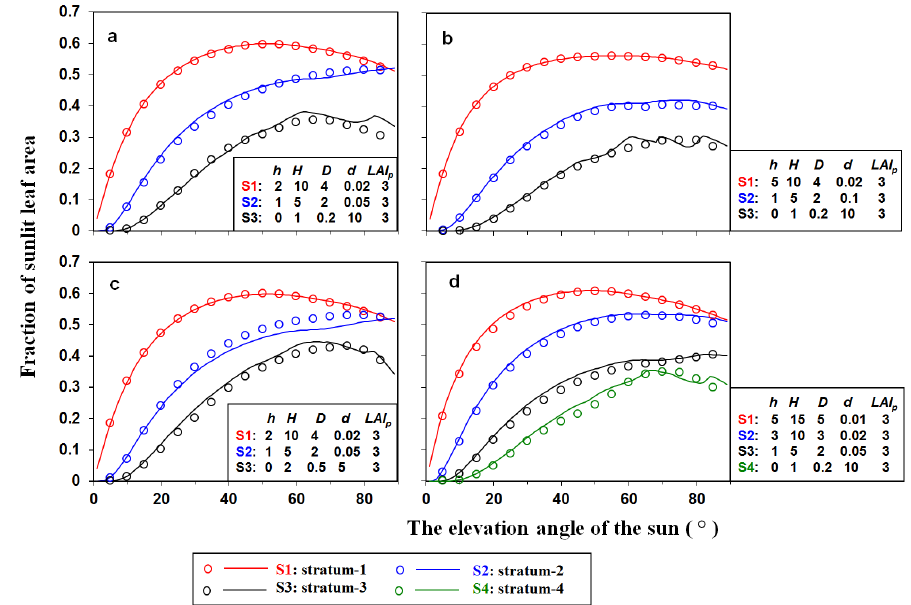
Figure 8. Comparisons of the calculated fractions of sunlit leaf area between the IPR model (curves) and the random approach (circles) for (a–c) three-stratum plant communities and for (d) four-stratum plant communities. Different colours are for different strata. The crown parameters are listed within or beside each panel: H and h are the heights of the top and bottom of the crown, respectively (m), D is the width of the crown (m), d is the density of plants (plantsm − 2 ) , and LAI p is the local leaf area index (m 2 leafm − 2